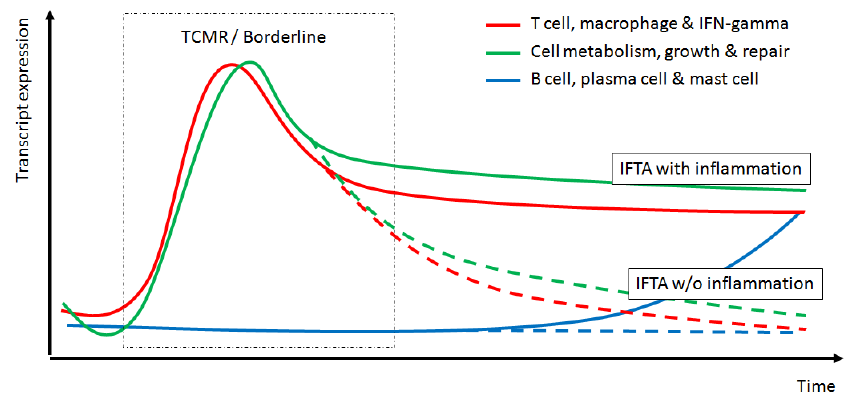
Figure 1. Hypothesized sequential modifications in the transcriptome for different gene sets and its correlation with histological changes. TCMR, T-cell mediated rejection; IFTA, interstitial fibrosis and tubular atrophy. Continuous lines depict transcriptome expression leading to IFTA with inflammation while dotted lines depict transcriptome expression leading to IFTA without inflammation.